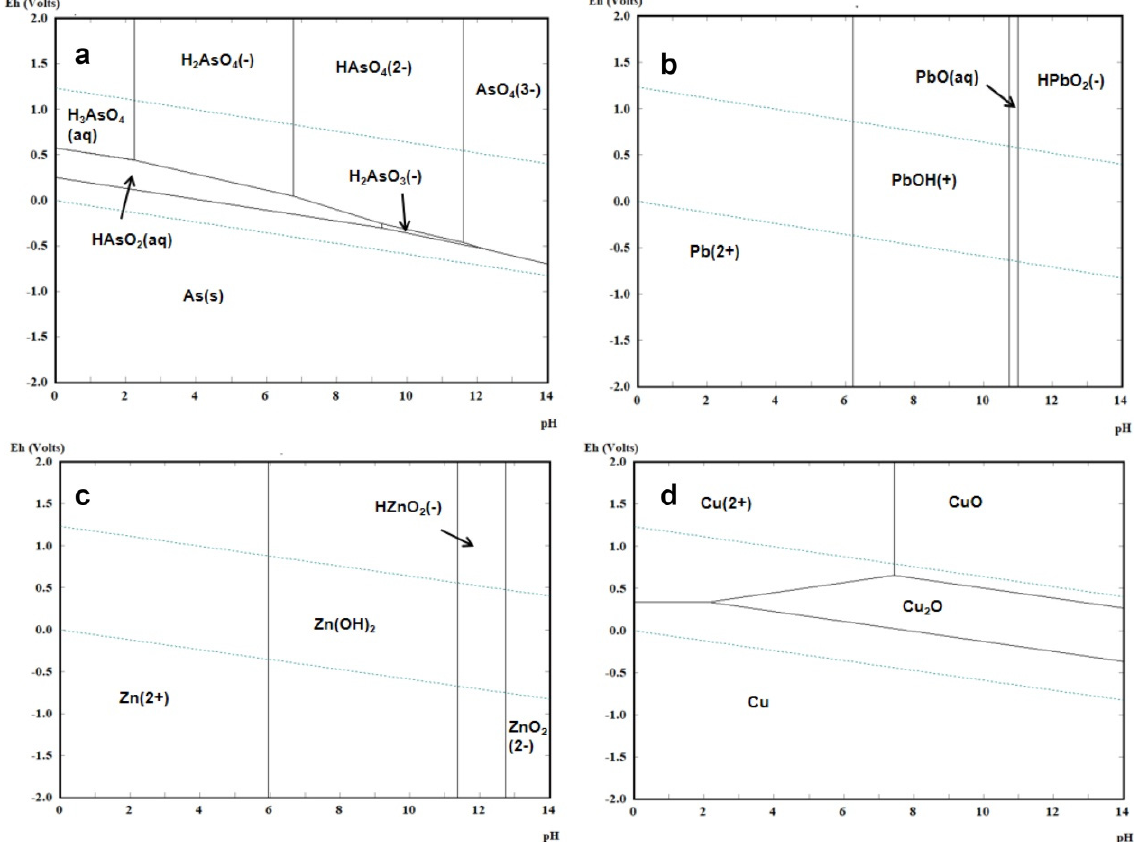
Figure 3. ( a ) Eh—pH diagrams of As, ( b ) Pb, ( c ) Zn, and ( d ) Cu, respectively.